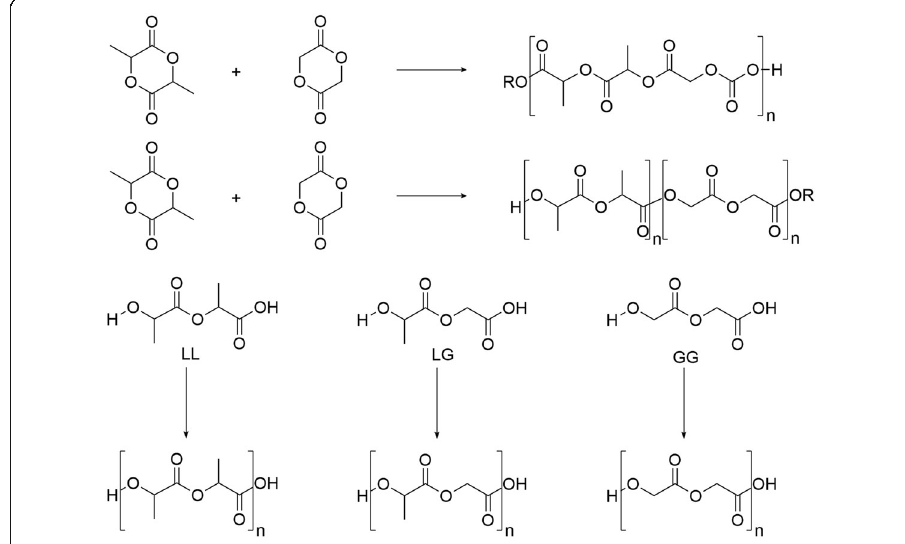
Fig. 6 (Top) Ring-opening polymerization (ROP) used to prepare repeating sequence (ideal) or random (real) copolymer. (Bottom) Segmer-assembly polymerization (SAP) used to prepare sequence polymers. L – lactic unit, G – glycolic